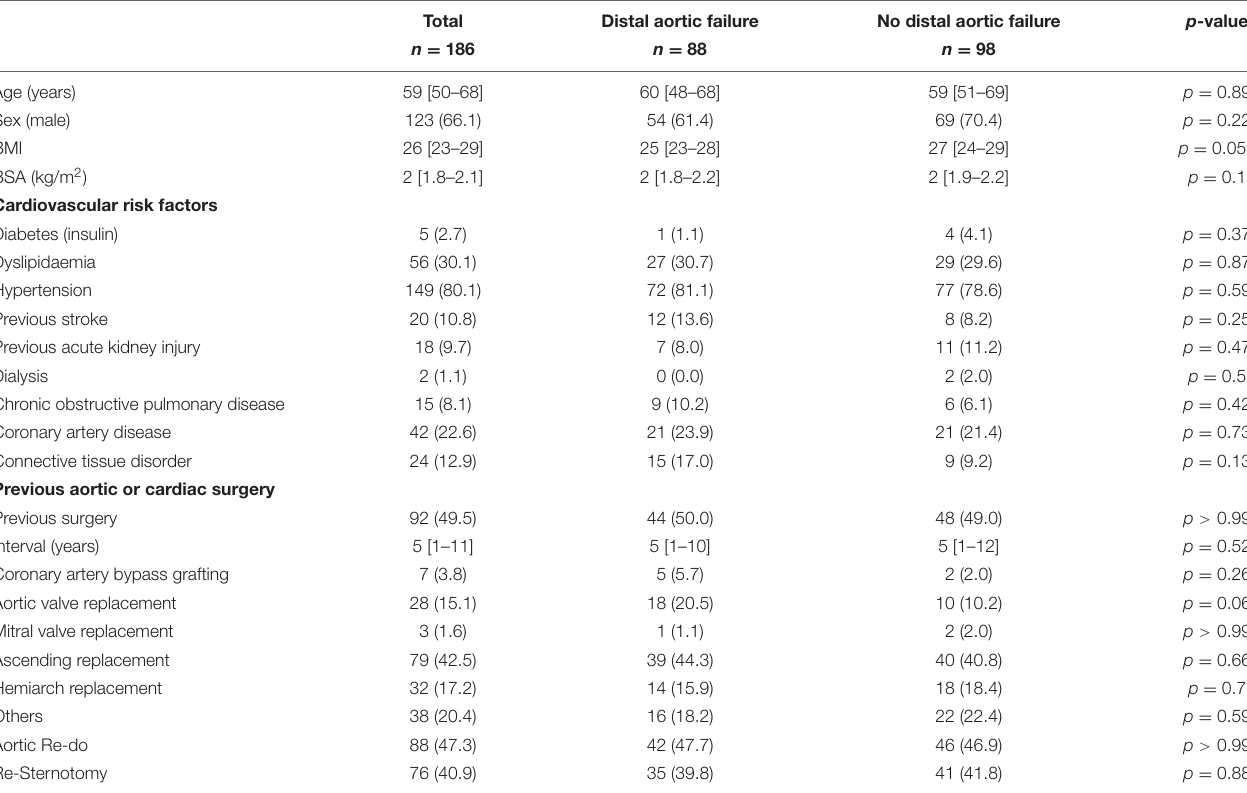
TABLE 1 | Demographic data and medical